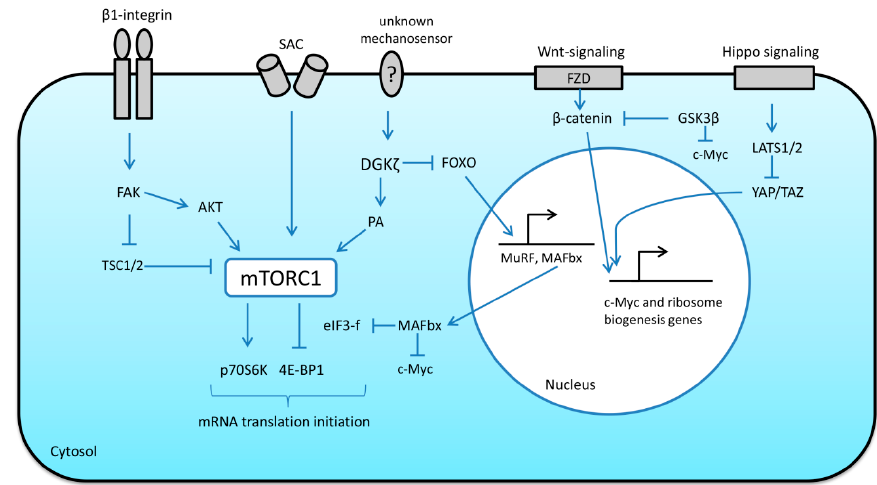
Figure 2. Simplified diagram depicting mechanoresponsive signaling pathways in skeletal muscle involved in the regulation of translational capacity and efficiency. Arrows indicate stimulatory signals, whereas T bars represent inhibitory signals. SAC—stretch-activated ion channels, FZD—frizzled protein (receptor), FAK—focal adhesion kinase, AKT—protein kinase B, TSC1/2—tuberous sclerosis complex1/2, DGK ζ —zeta isoform of diacylglycerol kinase, PA—phosphatidic acid, mTORC1—mammalian/mechanistic target of rapamycin complex 1, p70S6K —ribosomal protein S6 kinase p70, 4E-BP1—eukaryotic initiation factor 4E binding protein, FOXO—forkhead box O protein, MuRF1—muscle RING finger, MAFbx—muscle atrophy F-box, c-Myc—c-myelocytomatosis oncogene, eIF3f—eukaryotic initiation factor 3f, GSK3 β —glycogen synthase kinase-3 β , LATS1 / 2—large tumor suppressor kinase 1 / 2, YAP—Yes-associated protein, TAZ—transcriptional coactivator with PDZ-binding